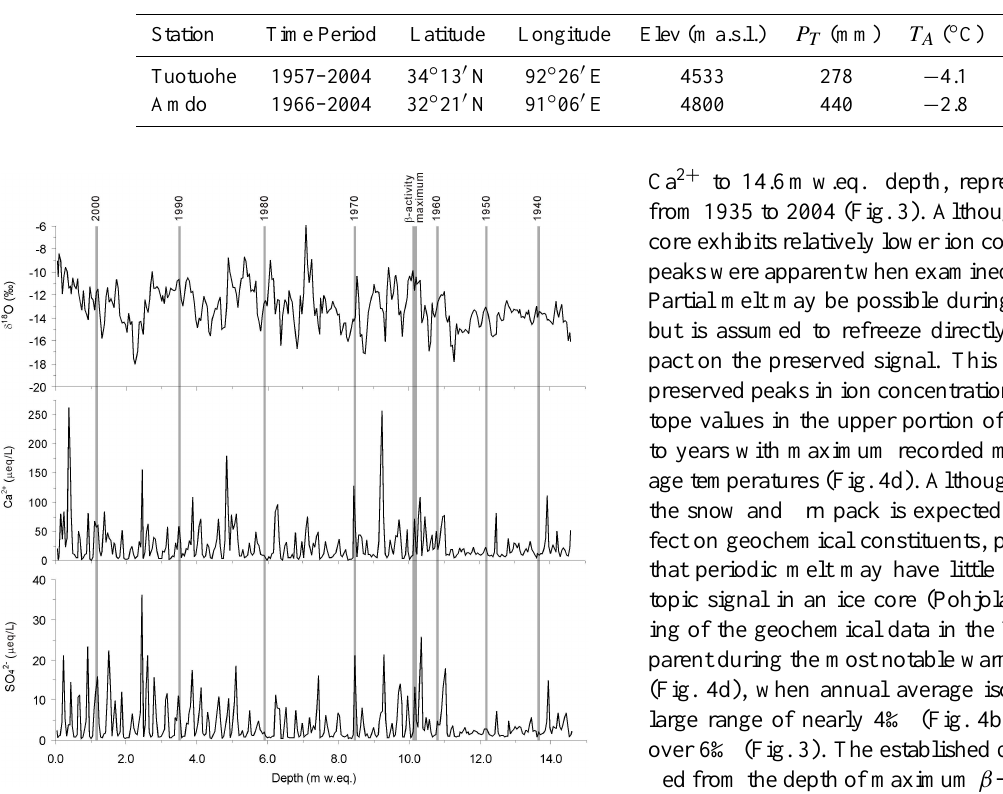
Fig. 3. δ 18 O profile for the upper 14.6mw.eq. depth shown with SO 2 − , Ca 2 + , and established depth-age 4